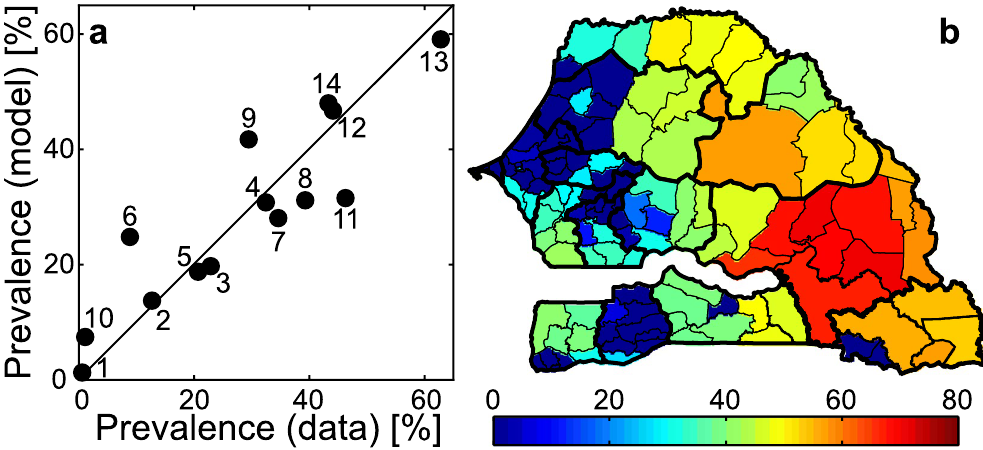
Figure 2. Reference model simulation and comparison with epidemiological evidence. ( a ) Quantitative agreement between simulated disease prevalence at the regional scale and the available data (labels as in Fig. 1b) for the best-fit model accounting for fine-grained spatial heterogeneity in transmission risk and human mobility estimated from CDRs (M4, reference model). ( b ) Projected schistosomiasis prevalence [% of people infected] at the scale of third-level administrative units as obtained from the reference model. Calibrated parameter values: = 5.5 · 10 − 3 [days − 1 ], χ = 2.2 · 10 − 6 [days − 1 parasites − 1 ], φ = . ⋅ − 4 3 10 1 , ξ = . ⋅ 1 1 10 2 . See Table 1 β 0 0